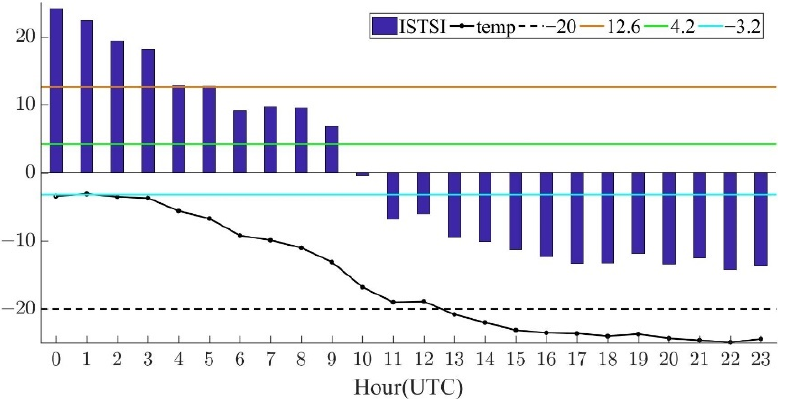
Figure 8. The 24 h change in temperature and ISTSI at Yongji station on 8 January 2022 (the unit of temperature is °C).